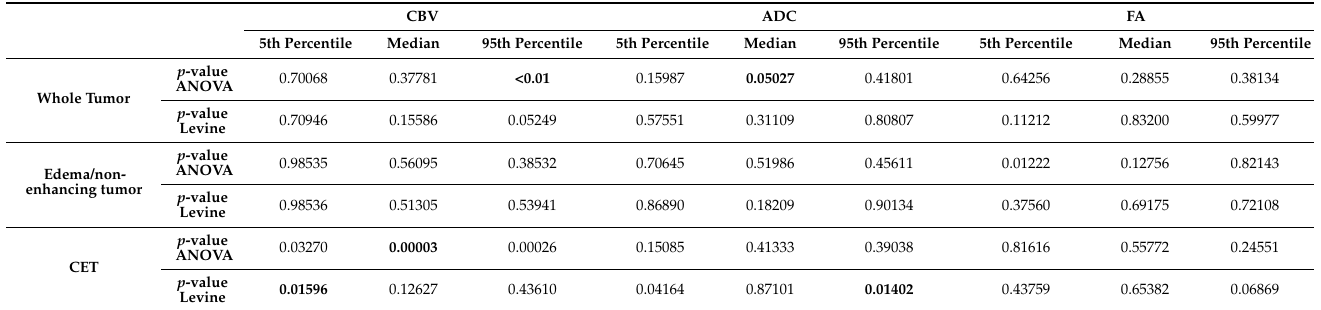
Table 2. Results of one-way ANOVA analysis between the 5th percentile, median, and 95th percentile of cerebral blood volume (CBV), apparent diffusion coefficient (ADC), and fractional anisotropy (FA) of glioblastoma, astrocytoma, and oligodendroglioma. Differences were assessed for the whole tumor volume, non-enhancing tumor/edema, and contrast-enhancing tumor (CET), respectively.